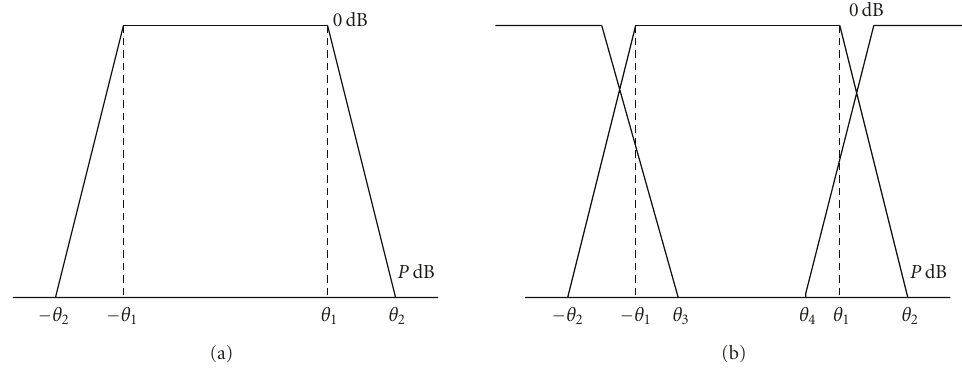
Figure 1: (a) Uplink/downlink antenna pattern model and (b) intersector interference